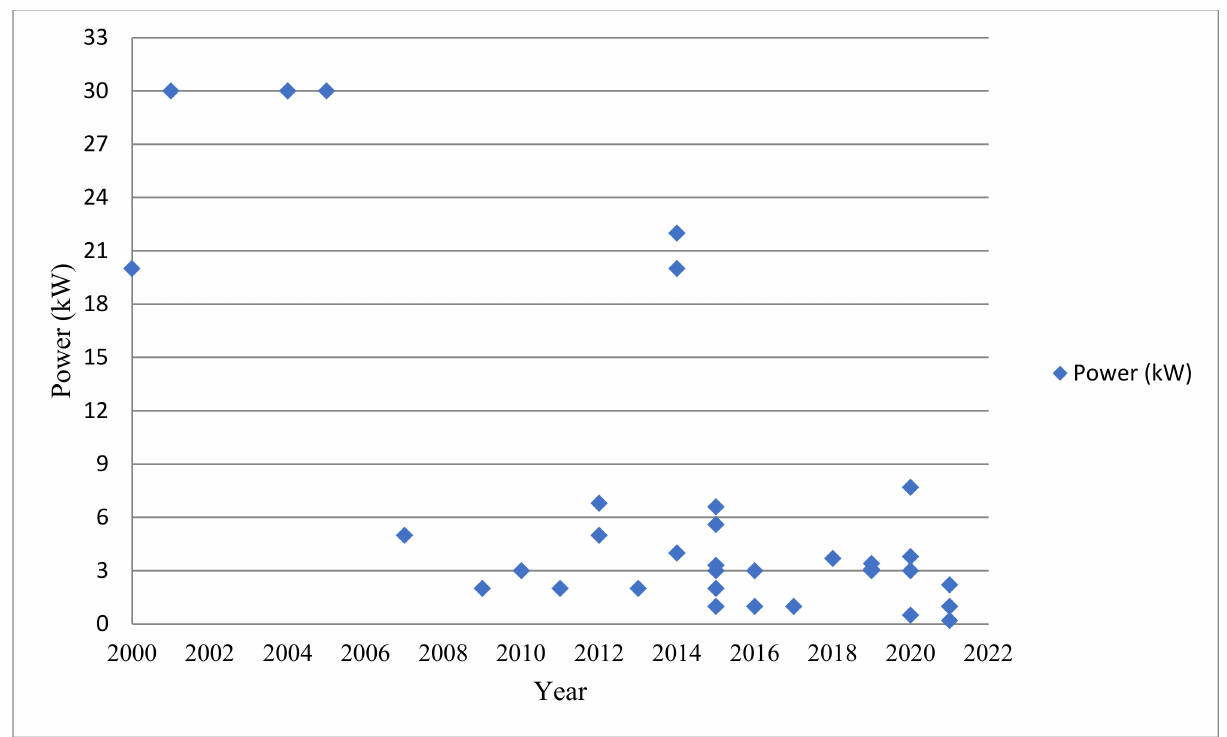
Figure 11. Power values selected in academic studies by years of